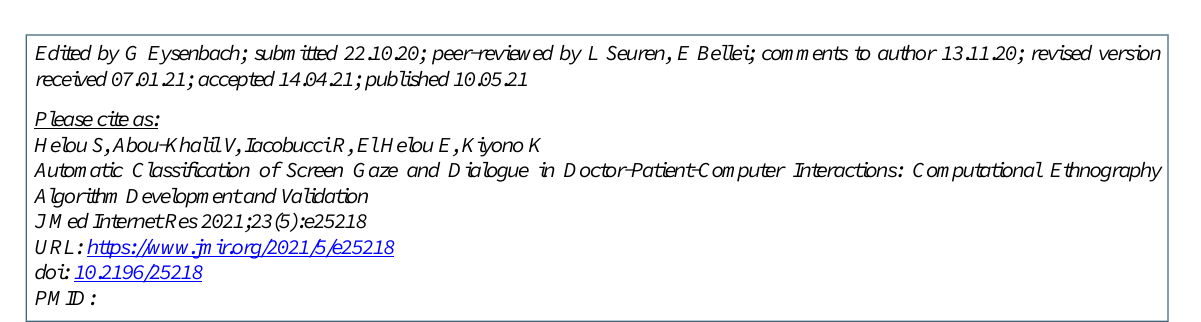
Algorithm Development and